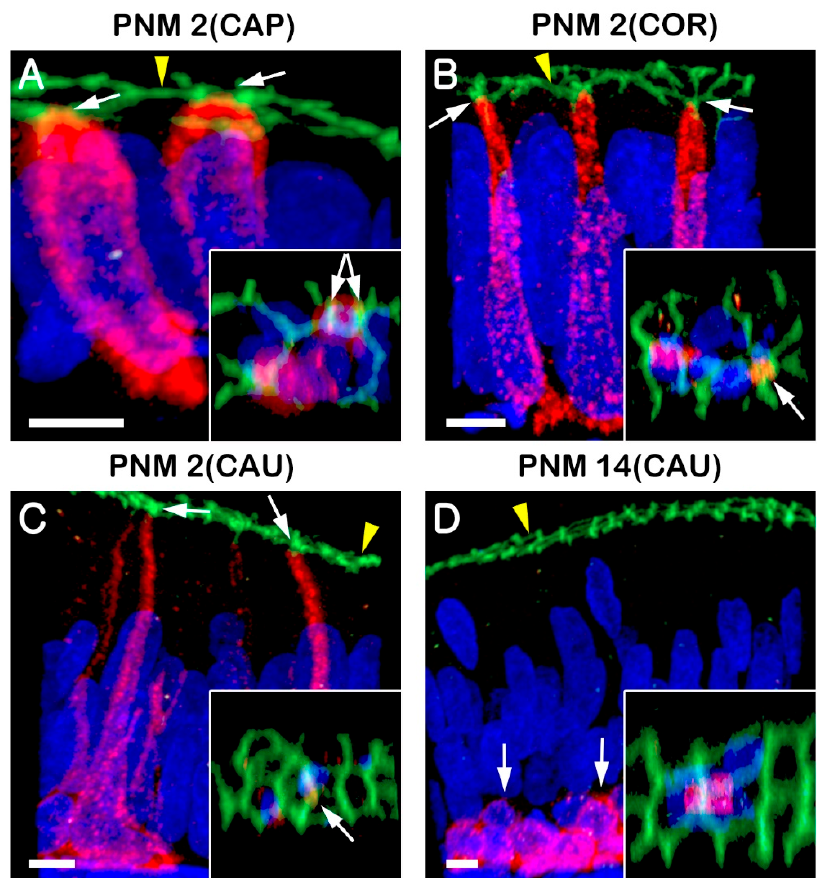
Figure 4. Basal cell projections in the goat epididymis. Basal cells were labeled for KRT5 (red), and tight junctions for ZO1 (green). During the first 2 months of postnatal development: ( A ) columnar-shaped BCs in contact with the tight junction labeled by ZO1 (arrows). ( B , C ) Basal cell projections passed through the tight junctions coming into contact with the luminal contents (arrows). ( D ) The arrows indicate BCs with no projections. The arrowheads indicate tight junctions. The insets show projected BCs to reach the tight junction (arrows). The nuclei were labeled with DAPI (blue). Bars = 5 µm.